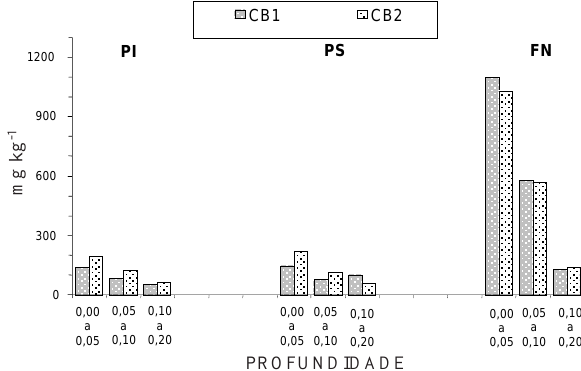
Figura 3. Carbono da biomassa microbiana nos agregados maiores e menores que 0,25 mm, respectivamente (CB1 e CB2), de solos sob plantio direto irrigado (PI), plantio direto de sequeiro (PS) e floresta nativa (FN), em três profundidades.